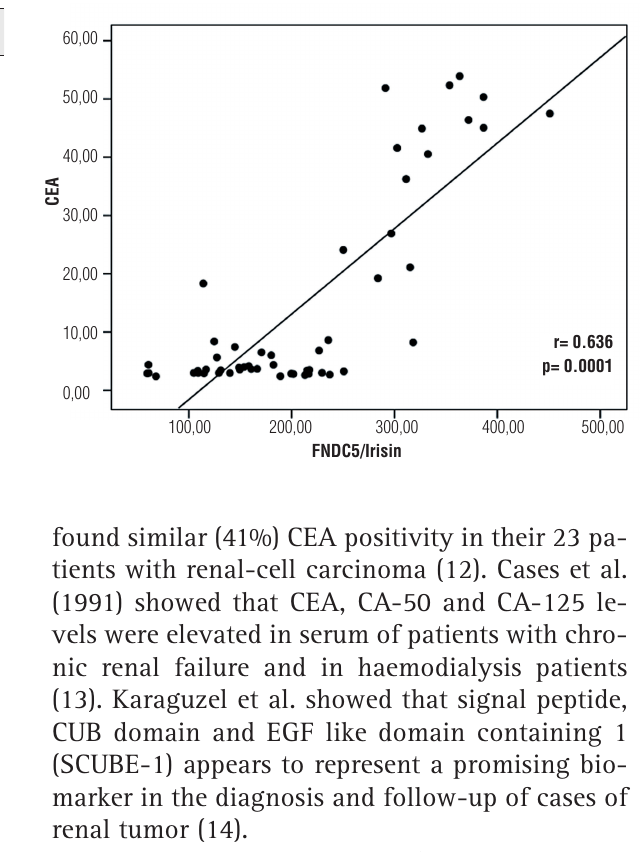
figure 2 - fNDc5/irisin and cEA